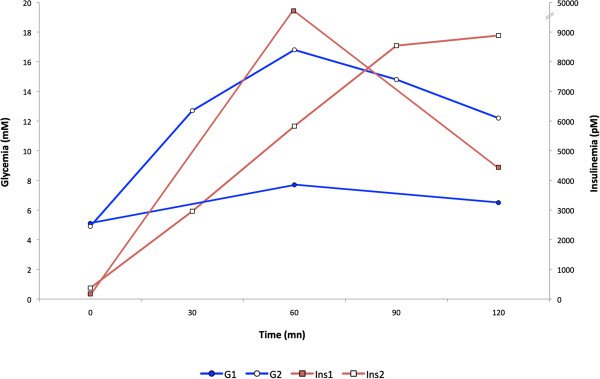
Baseline oral glucose tolerance tests of patients, before metformin therapy. G, glycemia (circles, blue), and Ins, insulinemia (squares, red) from patients 1 (filled symbols) and 2 (empty symbols) are depicted.